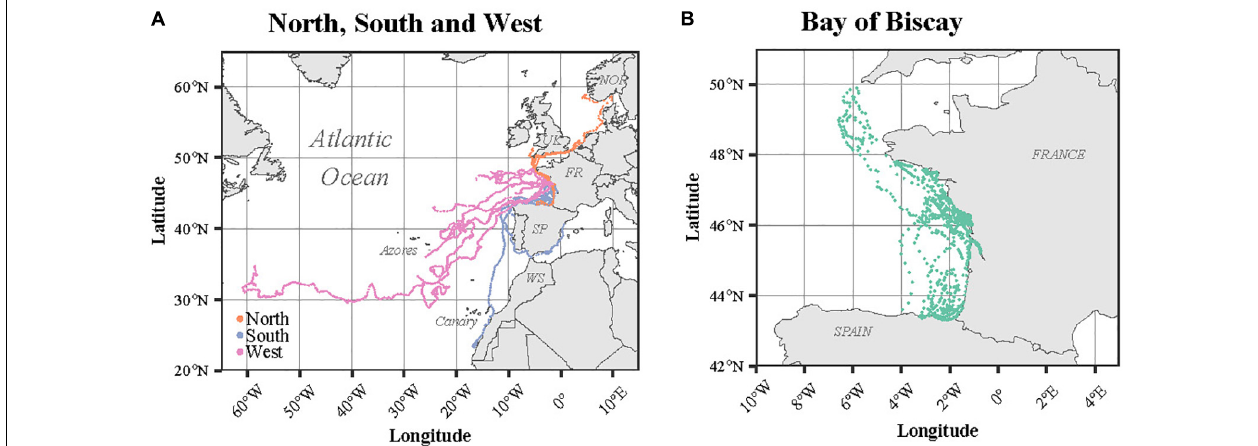
FIGURE 3 | Satellite tracks of the immature turtles according to their spatial pattern: (A) North ( n = 3), South ( n = 3) and West ( n = 10) and (B) Bay of Biscay ( n = 11). The names of the countries are indicated in capital letters: NOR (Norway), UK (United Kingdom), FR (France), SP (Spain), and WS (Western Sahara).